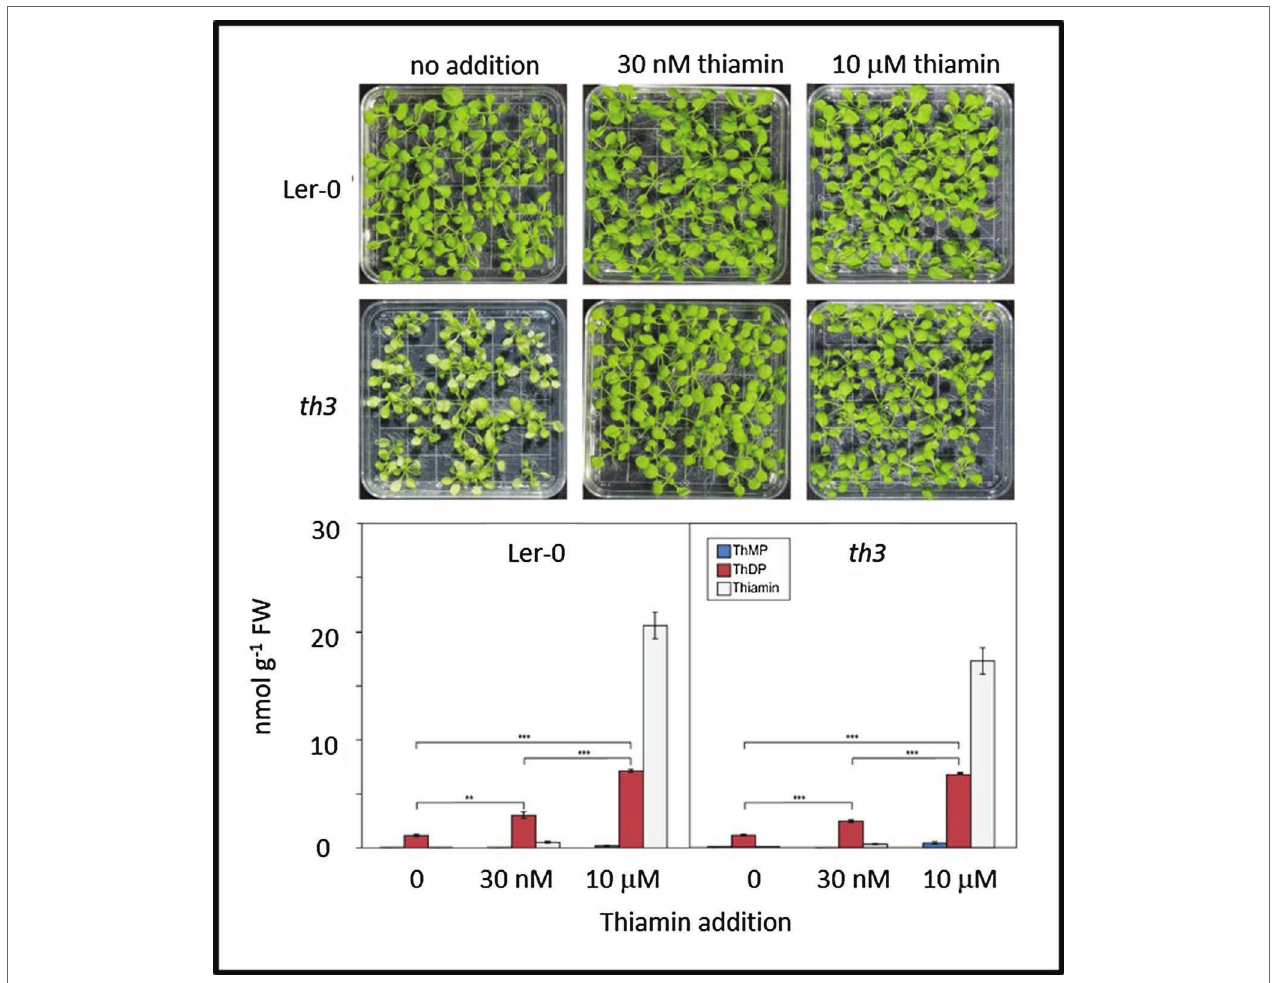
FIGURE 1 | Mutant th3 seedlings are rescued by thiamin but exhibit no discernible defects in thiamin biosynthesis. Top: phenotypes of wild type (Ler-0) and th3 seedlings grown on MS agar medium containing 0, 30 nM or 10 μM thiamin. Bottom: vitamer profiles of Ler-0 wild type and th3 seedlings grown on 0, 30 nM or 10 μM thiamin. ThMP, ThDP, and free thiamin were quantified as described in Mimura et al. (2016). Brackets indicate t -test comparisons: ** p < 0.01 and *** p < 0.001. Error bars indicate standard error of the mean for three